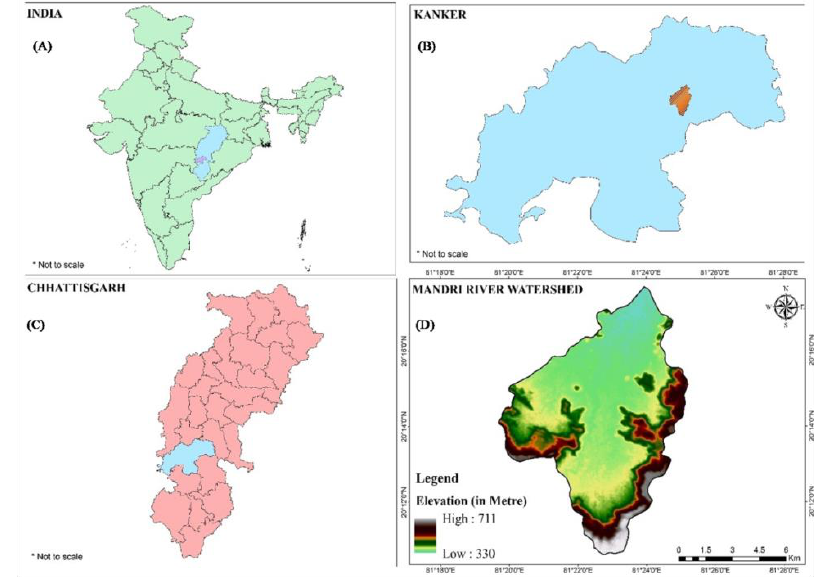
Figure 1: Study area map of Mandri river watershed